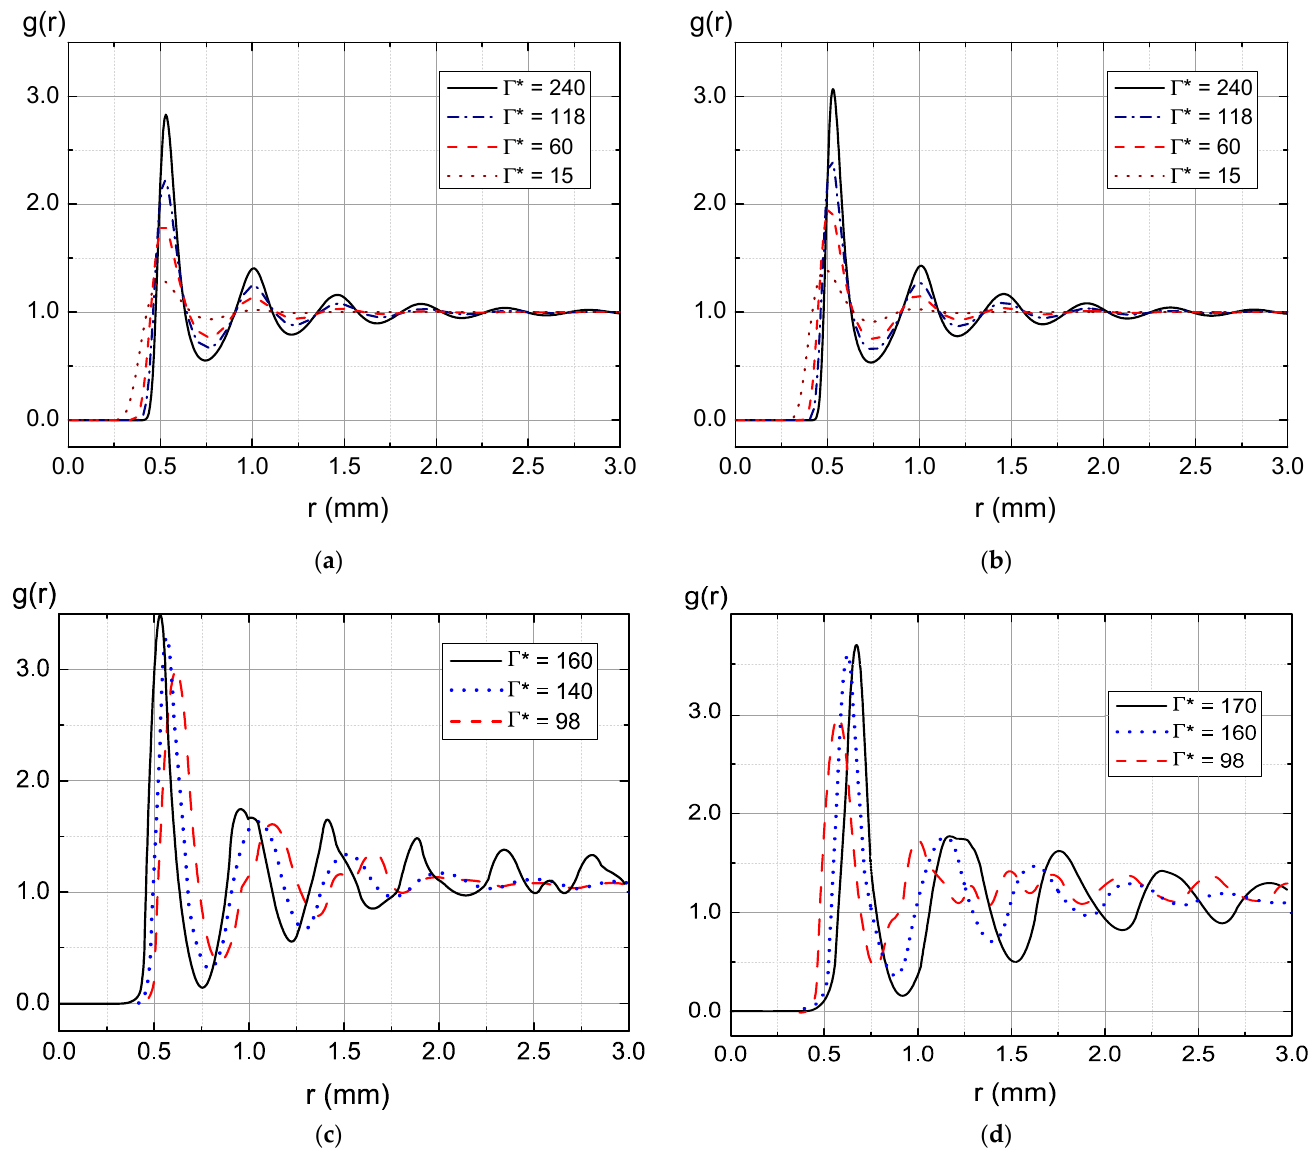
Figure 10. Pair correlation functions g ( r ), ( a , b ) determined by numeric solution of the Ornstein–Zernike equation in HNC approximation under various values of effective coupling parameters Γ * and n d = 8.0 × 10 3 cm − 3 , and ( c , d ) obtained in experiments under the following parameters: ( a ) η = 5.53, R D = 1/ k D = 293.3 μ m, λ = 1.7, z d = − 1687.7; ( b ) η = 0 ( W i = 0), R D = 113.4 μ m, λ = 4.4, z d = − 3420.6; ( c ) Discharge power W = 13.1 W, pressure P = 3–5 Pa; ( d ) Discharge power W = 4.4–16.7 W, pressure P = 5 Pa.